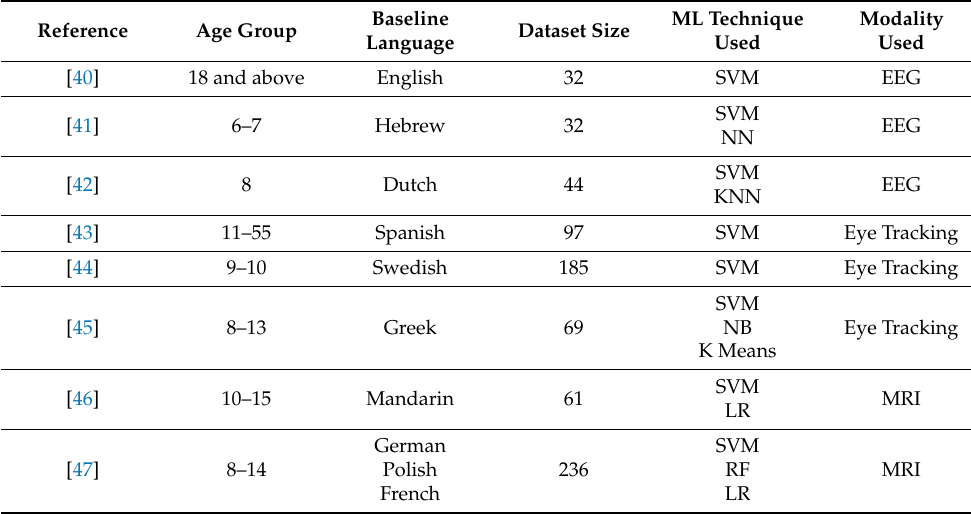
Table 1. Summary of related works on dyslexia